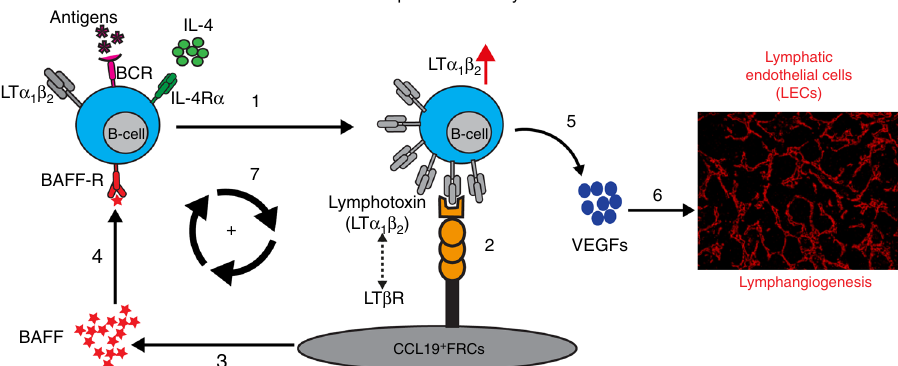
Fig. 8 Schematic of FRC – B cell interactions resulting in mLN lymphangiogenesis following Hp infection. Lymphotoxin expression by IL-4- and antigen- activated B cells (1) signals to LT β R expressed by FRCs (2) to promote the expression of BAFF (3). BAFF then synergizes with IL-4 to further upregulate lymphotoxin expression on antigen-activated B cells in a feed-forward manner that acts to amplify total BAFF levels (4). BAFF and IL-4 then synergize to promote VEGF production by B cells (5) which drives helminth-induced lymphangiogenesis and continued DC accumulation within the mLN (6). FRC-derived BAFF also stimulates lymphotoxin expression by interacting B cells creating a feed-forward loop that furhter promotes FRC activation